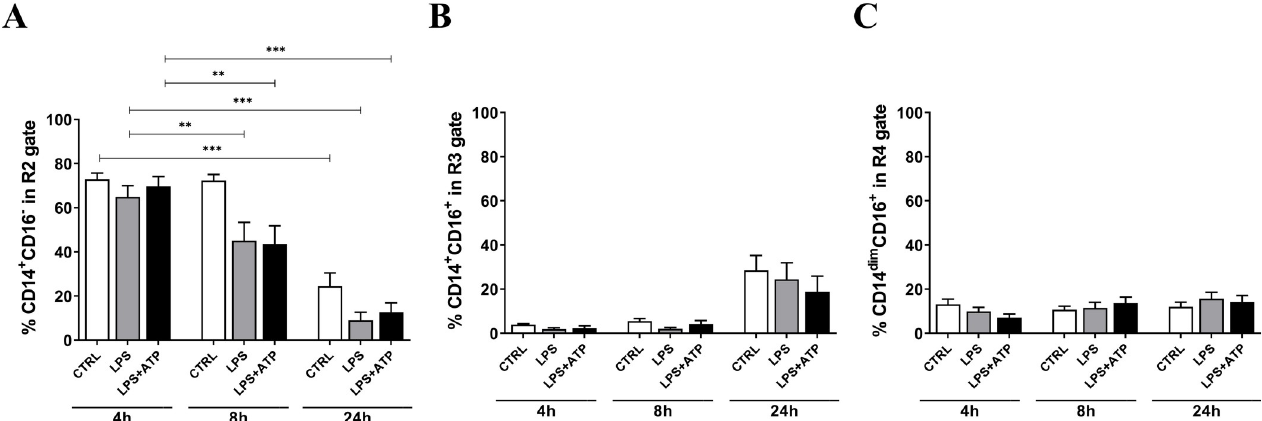
Fig 4. Monocytes phenotypically change during stimulation over time. Percentage expression of CD14 + CD16 − monocytes (A), CD14 + CD16 + monocytes (B) and CD14 dim CD16 + monocytes (C). Data are expressed as mean value ± SEM of each stimulation condition, n = 6. �� p < 0.005 and ��� p < 0.0001 analyzed by mixed effects analysis with Dunnett’s multiple comparison test.